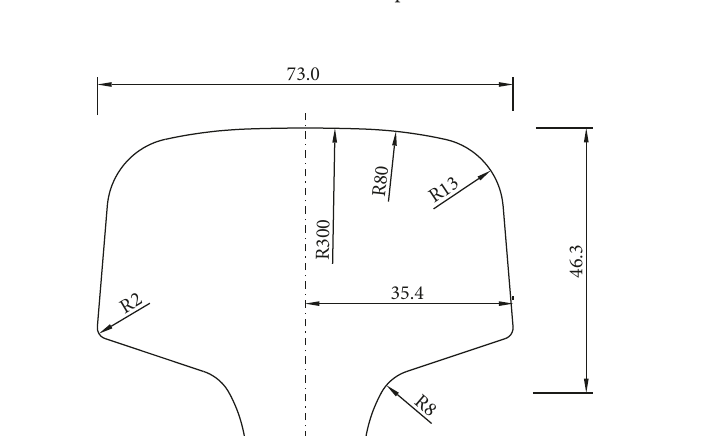
Figure 2: Wheel profile.